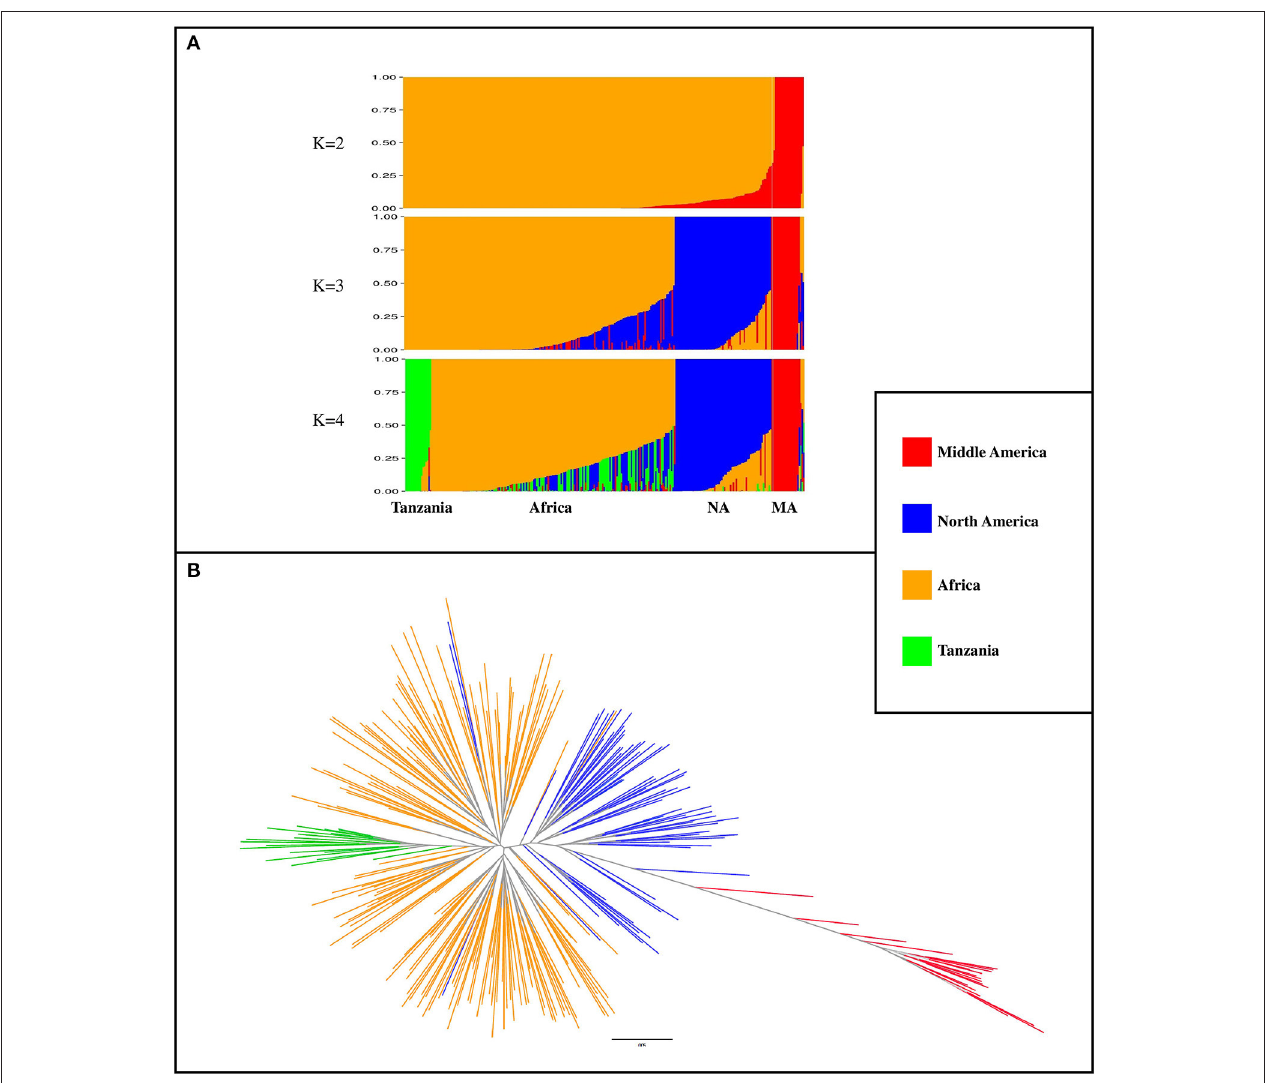
FIGURE 2 | Population classification using a subset of 3,668 markers that had LD r 2 ≤ 0.1 (markers in linkage equilibrium). (A) Population structure from K = 2 to K = 4. K indicates the number of subpopulations. NA, North America; MA, Middle America (B) phylogenetic tree of genotypes, constructed by using SNPhylo. The colors of subpopulations were the same as population structure plot ( K =